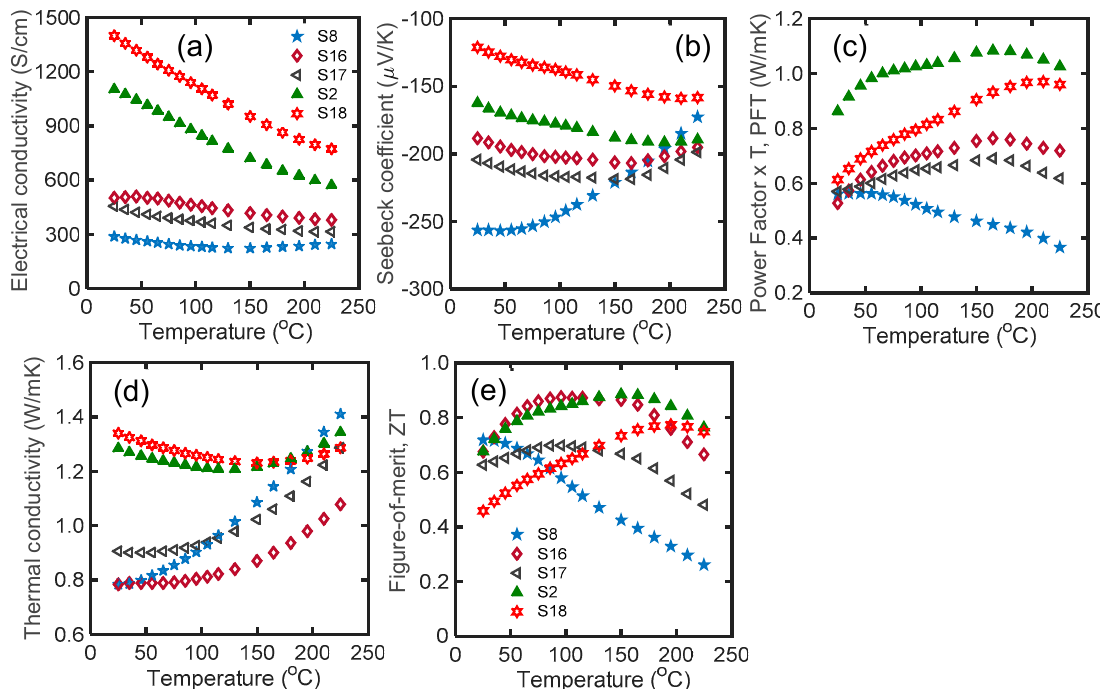
Figure 6. ( a ) Electrical conductivity; ( b ) Seebeck coefficient; ( c ) PFT; ( d ) thermal conductivity; and ( e ) zT of S6, S11, S12, S2, and S13 samples as a function of temperature in the range of 25 °C to 225 °C. According to Table 1, the composition and processing of the samples are as follows: S6: Bi 2.0 Te 2.7 Se 0.3 - 2.5% glass, SPS at 540 °C for 1 min; S11: Bi 2.0 Te 2.7 Se 0.3 -2.5% glass, SPS at 310 °C for 1 min, microwave processed and post SPS at 450 °C; S12: Bi 2.0 Te 2.7 Se 0.3 -2.5% glass, SPS at 270 °C for 1 min, microwave processed and post SPS at 450 °C; S2: Bi 2 Te 3 -6 at. % Se, SPS at 540 °C for 1 min, microwave processed and post SPS at 450 °C; and S13: Bi 2 Te 3 -6 at. % Se, SPS at 310 °C for 1 min, microwave processed and SPS at 450 °C.